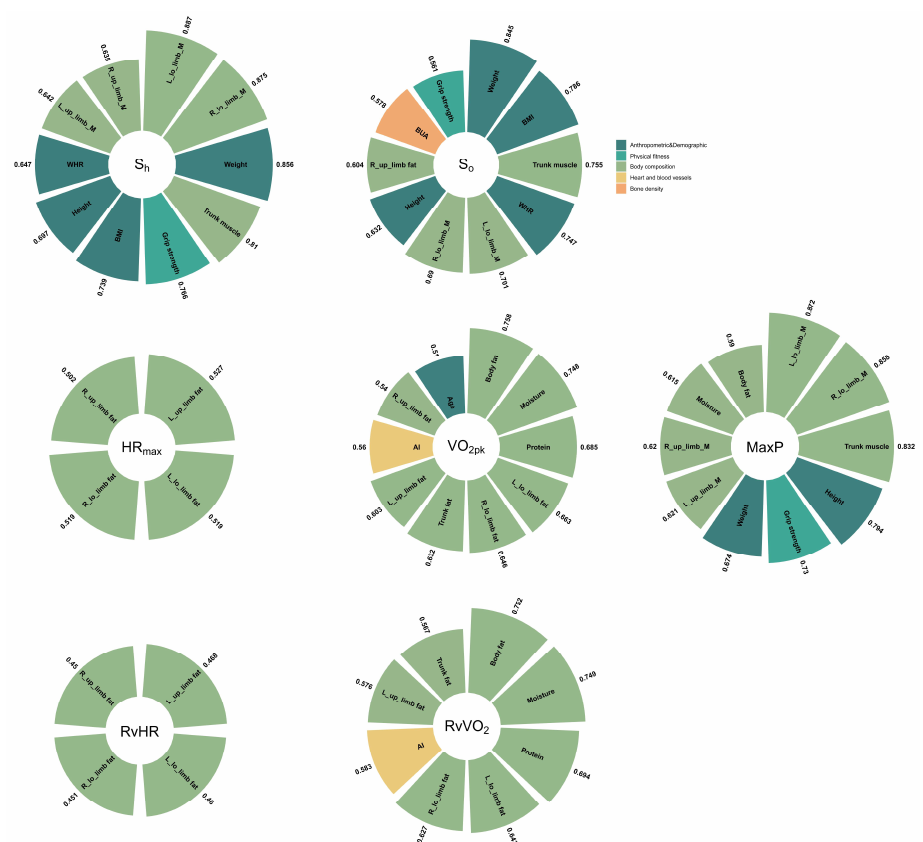
Figure 4. Details of the Non-In data with the relationships ( p < 0.001) to each of the exercise data for the participants younger than 40. The different colors represent the specific categories to which the data belong. The numbers outside the sector represent their correlation values.